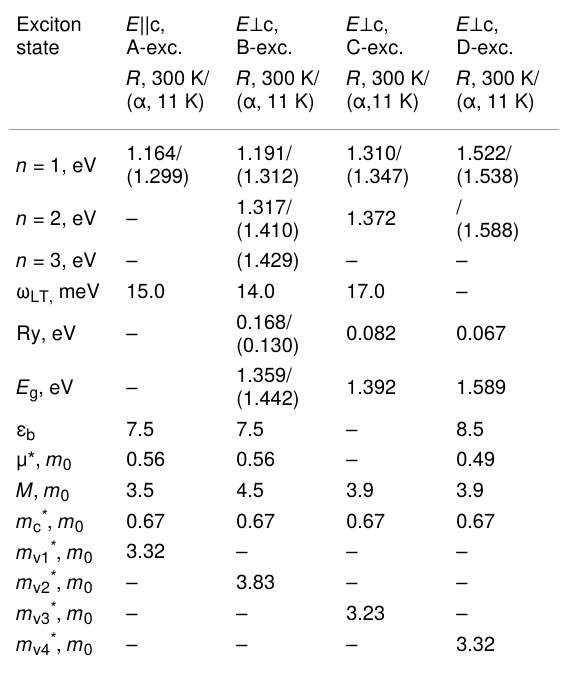
Table 2: Exciton parameters of the Sb 2 Se 3 crystals (data outside brackets: from the reflection spectra, data inside brackets: from the absorption